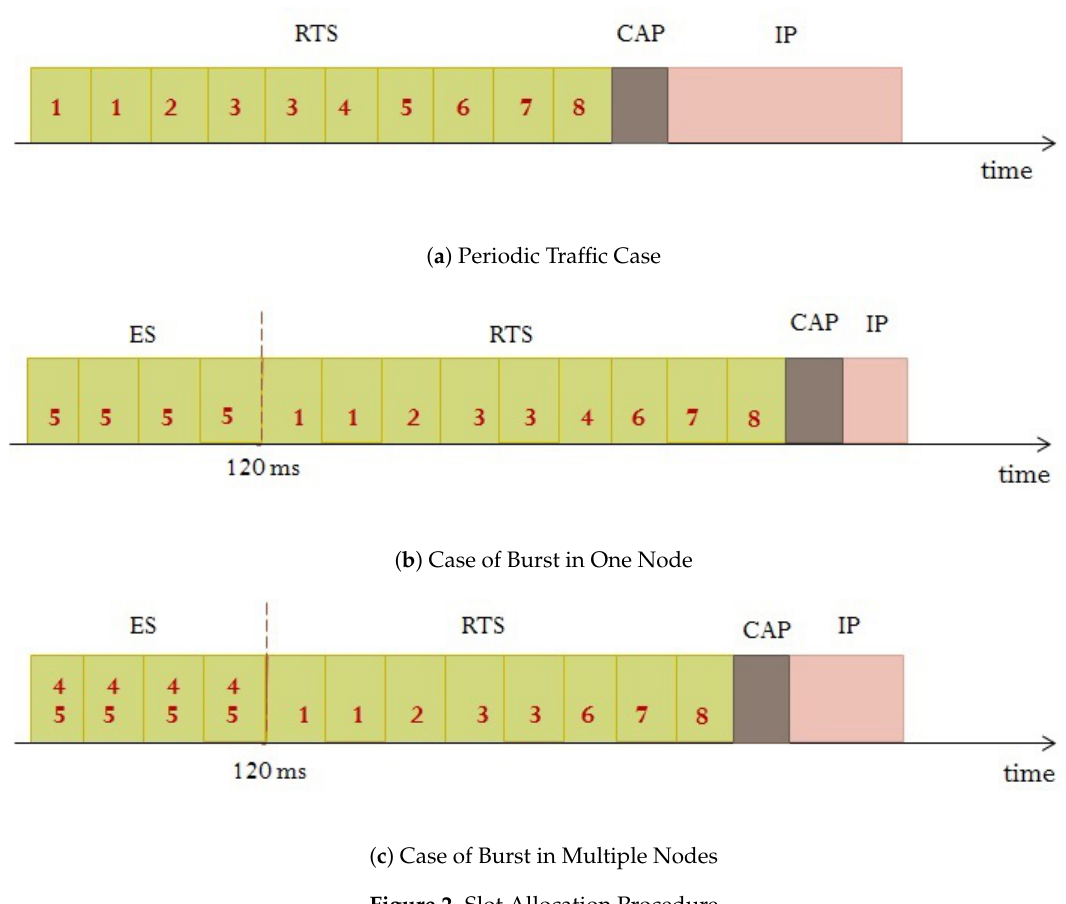
Figure 2. Slot Allocation